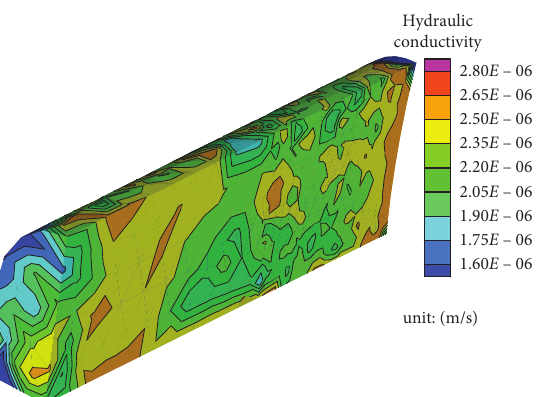
Figure 12: Water discharge of the working face evolves with the increase of reduction factor.